Question: Reading the figure, is the described quantity rising or falling?
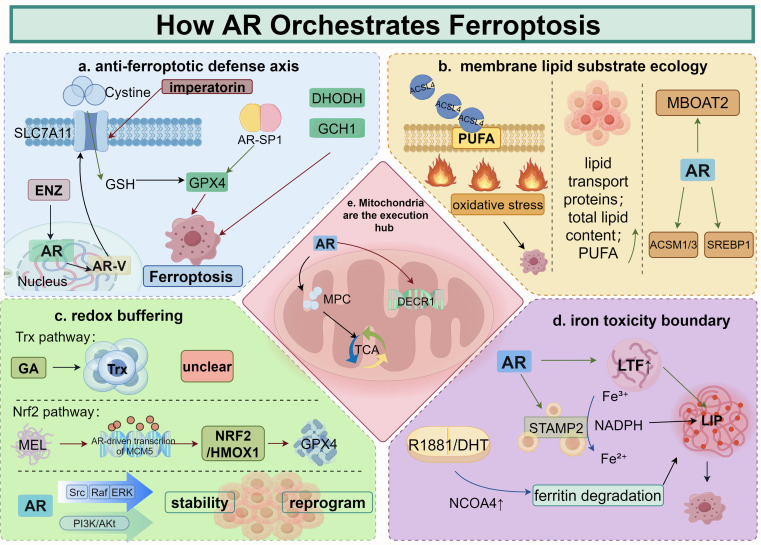
Answer: increasing